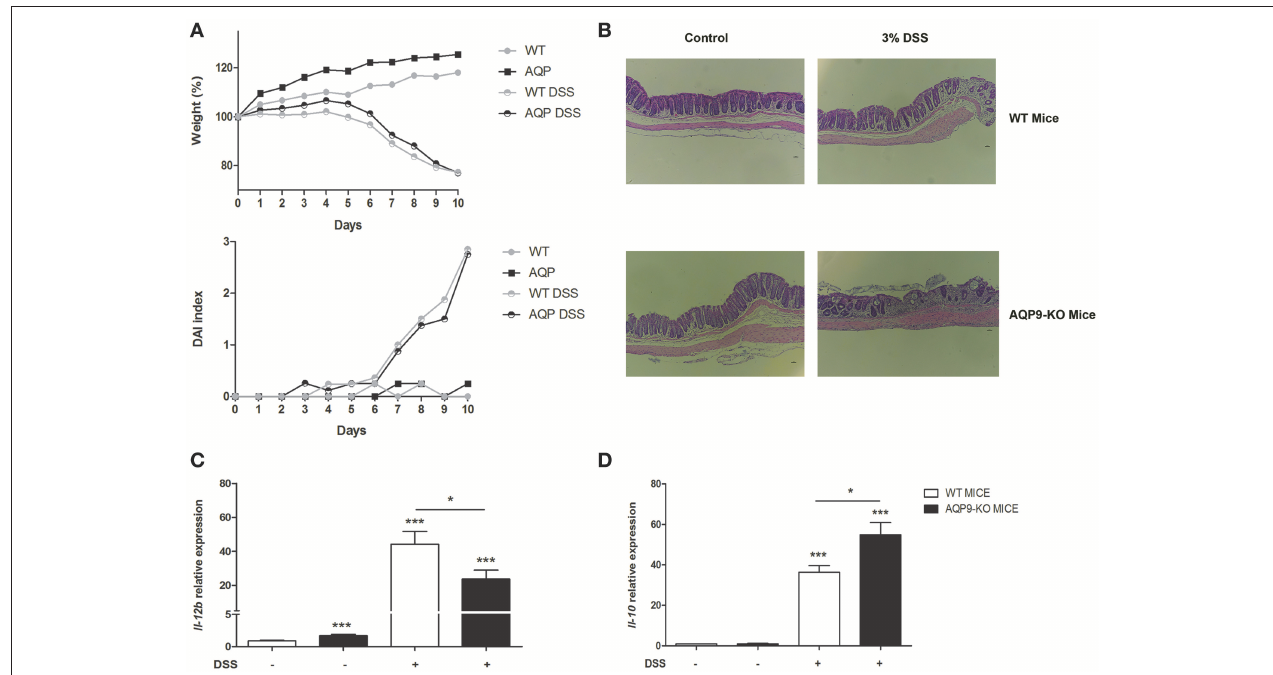
FIGURE 7 | Experimental colitis in Aqp9-KO mice. Acute inflammation was induced by 3% of DSS for 7 days, followed by 4 days of recovery. Weight was recorded every day (A) , at day 11 colon morphology was analyzed (B) . The expression of Il-12 (C) and Il-10 (D) was assessed in the colon of WT and Aqp9-KO mice. * P < 0.05, *** P <